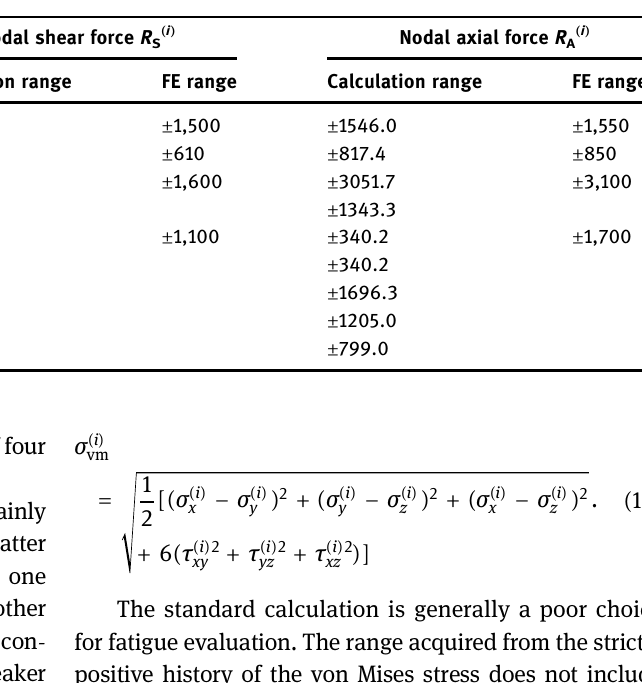
Table 7: Transfer coefficient from nodal force to the six - component stress and initial stress